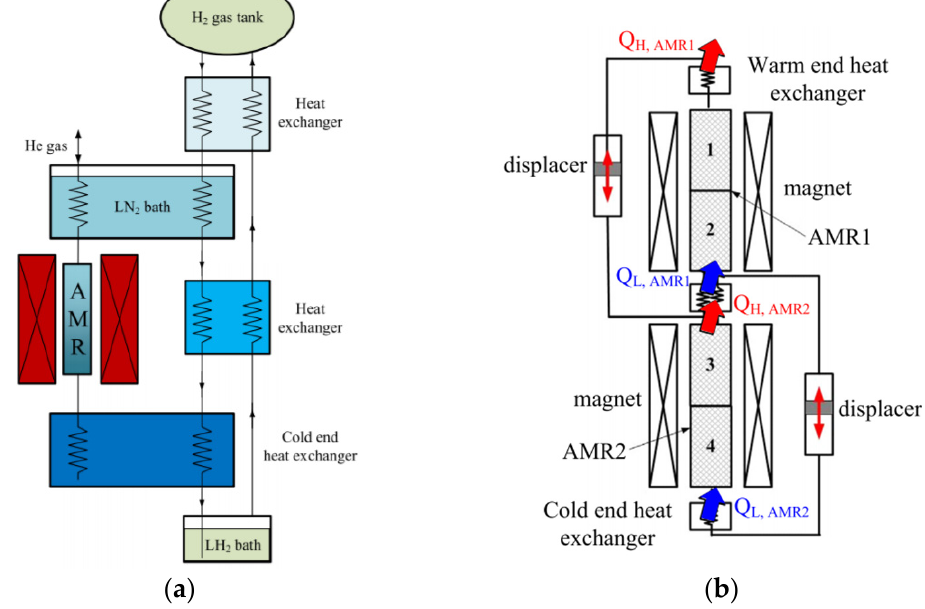
Figure 22. Schematic diagram representing ( a ) the whole system and ( b ) the two-stage AMRR [79]. Schroeder and Brehob (2016) [83] did a 1-D model computed with python for a